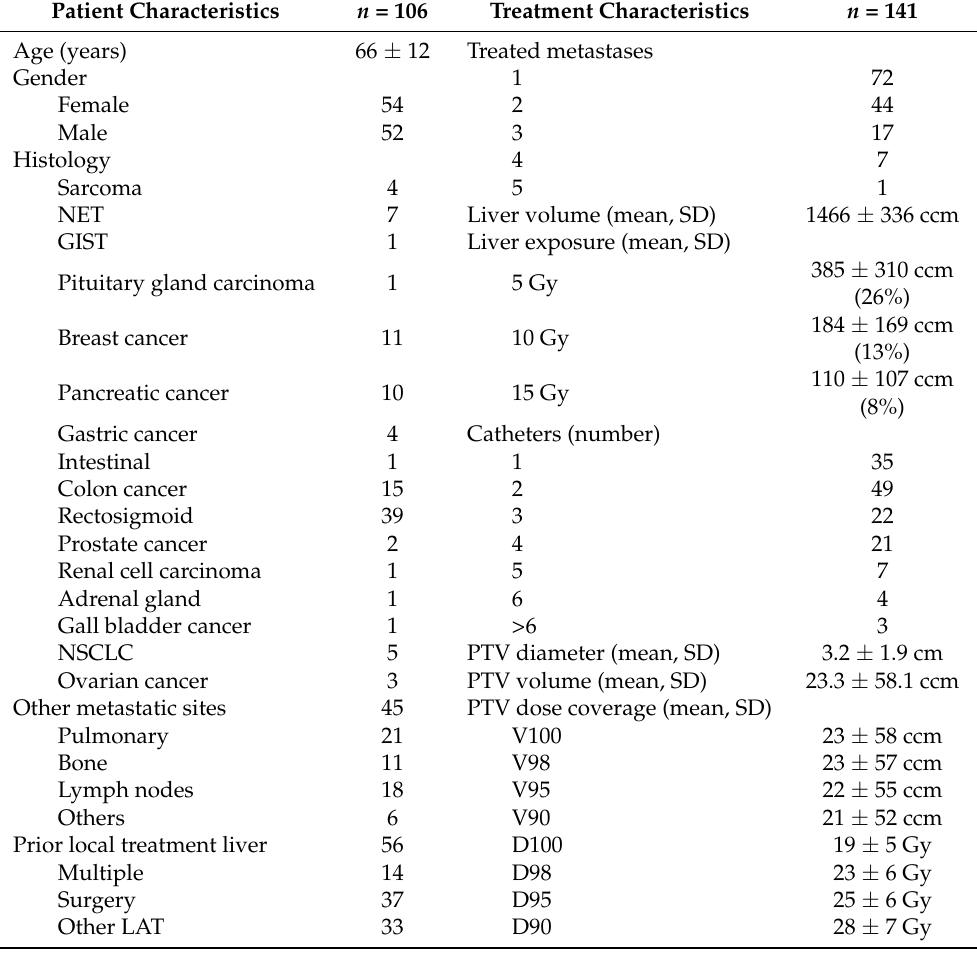
Table 1. Patient and treatment